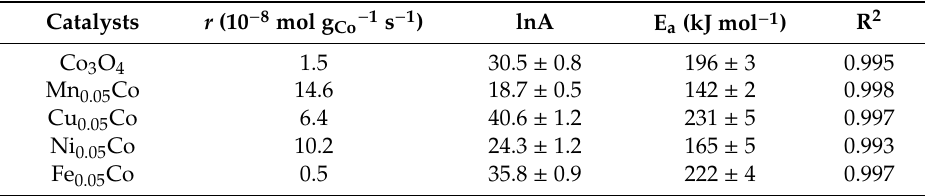
Table 4. Reaction rates (r) at 210 ◦ C, apparent pre-exponential factors (A), apparent activation energies (E a ), and coe ffi cient of determination (R 2 ) for toluene oxidation over various catalysts (reaction conditions: toluene concentration = 1000 ppm, O 2 concentration = 21 vol.%, and WHSV = 40,000 mL h − 1 g − 1